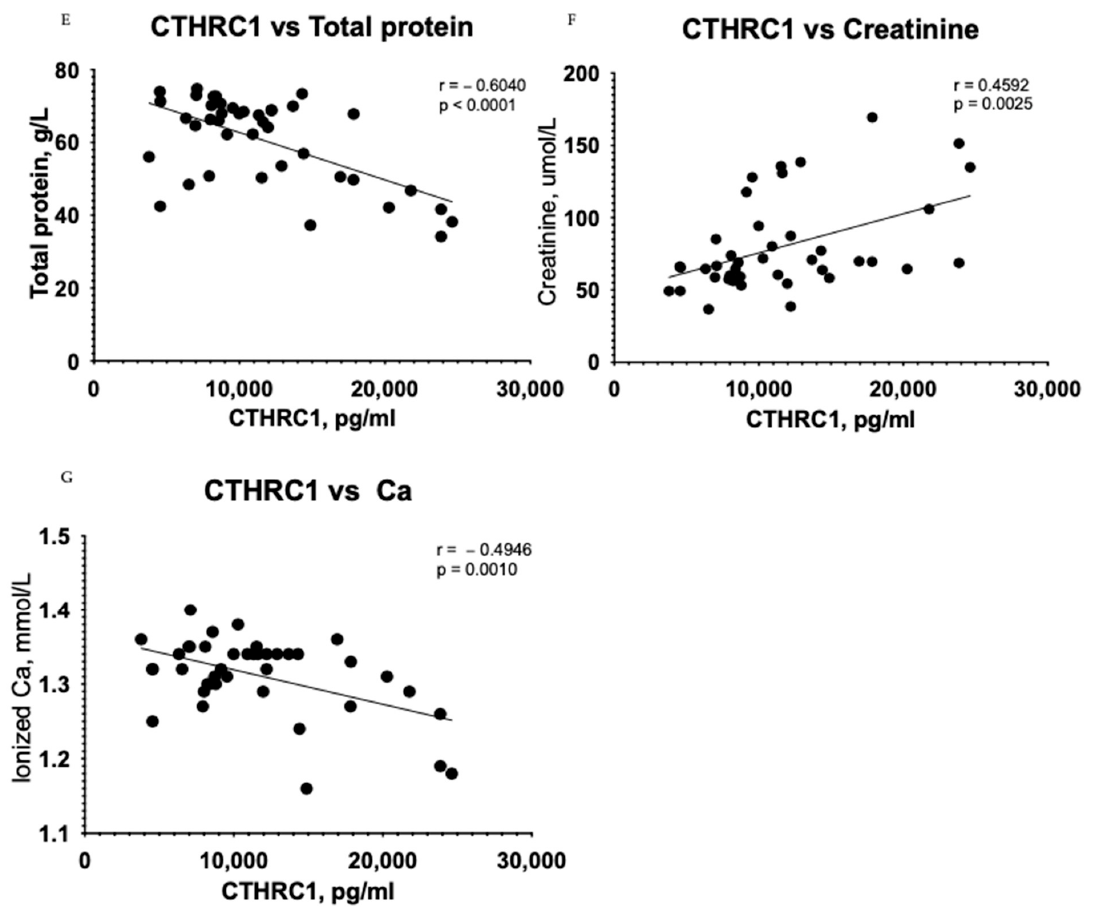
Figure 3. Correlation between plasma levels of CTHRC1 and notable clinical measures in all subjects (Control + CKD groups). The relationship between variables was evaluated using Pearson’s corre- lation test. Trend lines indicate linear correlation. Pearson’s (r) coefficient and the corresponding p -values are shown on each plot. Scatter plot graphs illustrating correlation between ( A ) CTHRC1 and uric acid, ( B ) CTHRC1 and total protein collected in 24 h in urine, ( C ) CTHRC1 and cholesterol, ( D ) CTHRC1 and urea, ( E ) CTHRC1 and plasma total protein levels, ( F ) CTHRC1 and creatinine, ( G ) CTHRC1 and ionized calcium levels.